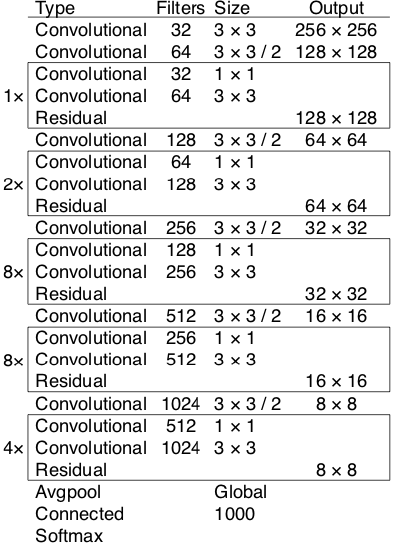
Figure 7. Darknet53